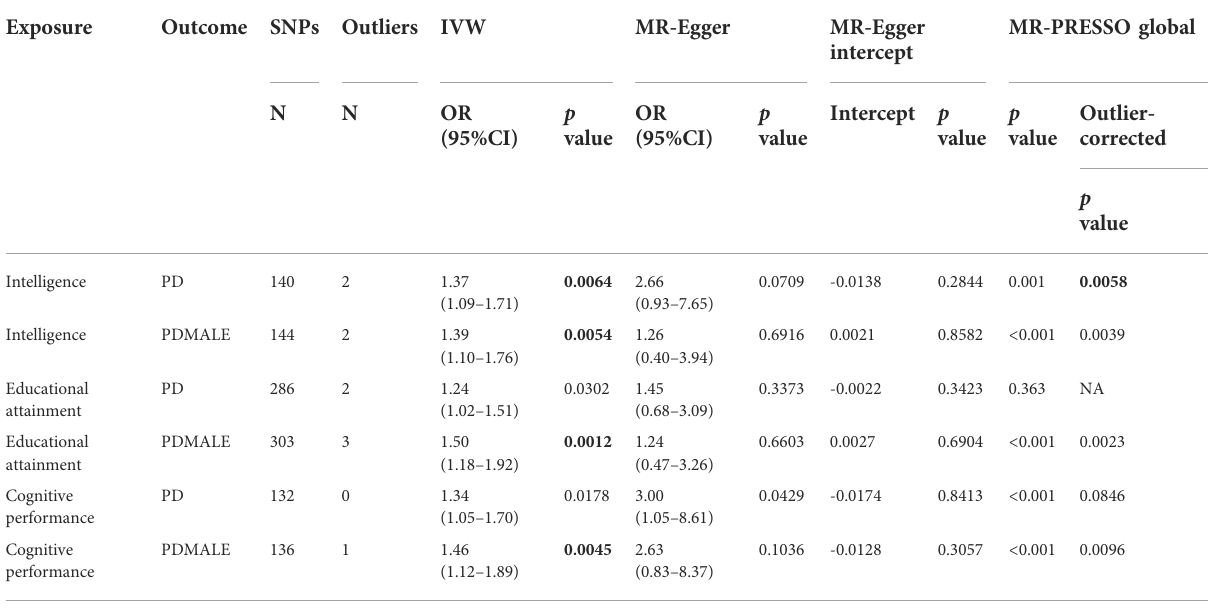
Bold numbers indicate that p value is statistically signi fi cant. IVW, inverse-variance weighted; MR-PRESSO, MR pleiotropy residual sum and outlier; OR, odds; CI, con fi dential; PD, Parkinson ’ s disease (regardless of gender); PDMALE, PD among